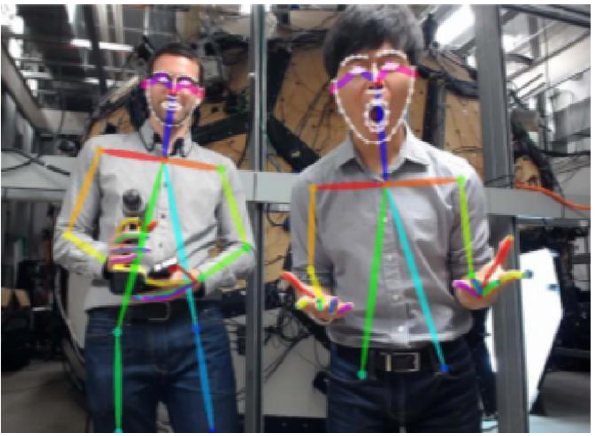
Figure 1. OpenPose detects the key points of body posture, facial expression, hands, and legs of multiple people at the same time. Photo credits: https://arxiv.org/pdf/1812.08008.pdf (access date: 1 October 2022).